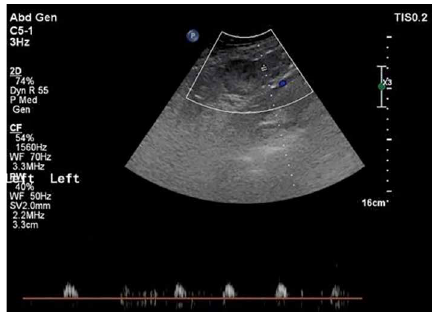
Figure 1: Absent Doppler flow to the enlarged left ovary.